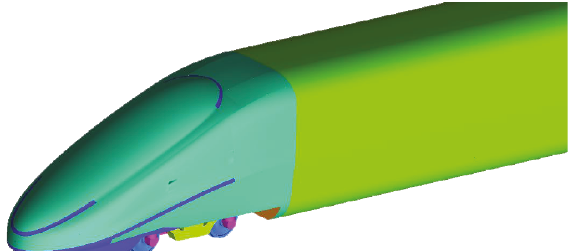
Figure 6: Engineering application head type of the hummingbird bionic design.